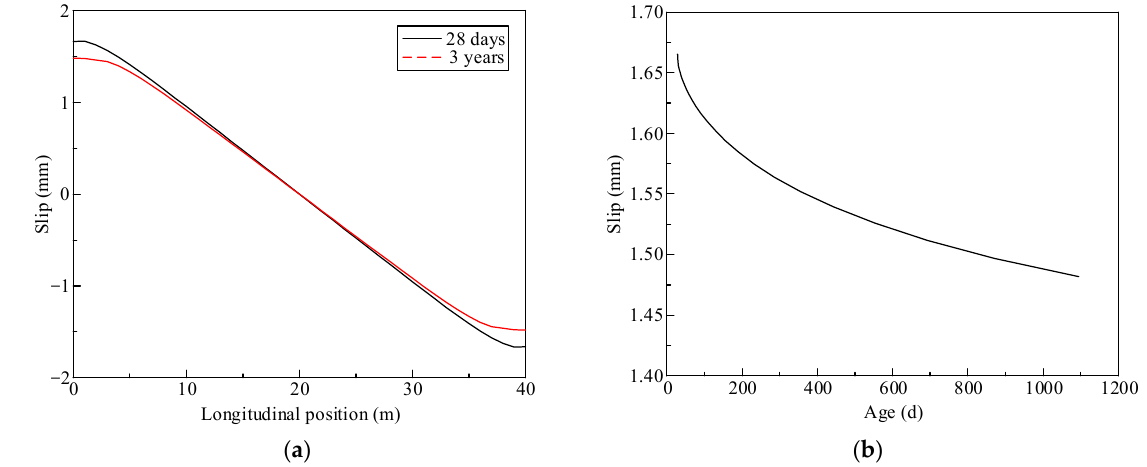
Figure 14. Interface slip of the composite beam (time-dependent analysis). ( a ) Distribution along span; ( b ) Change with time at support section.